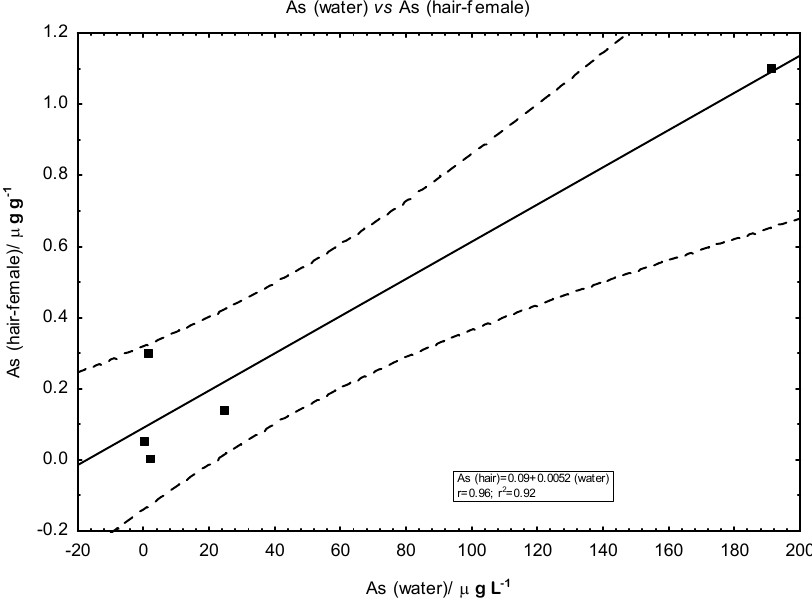
Figure 3. Relationship between median arsenic concentrations in water and hair among female ex- aminees.